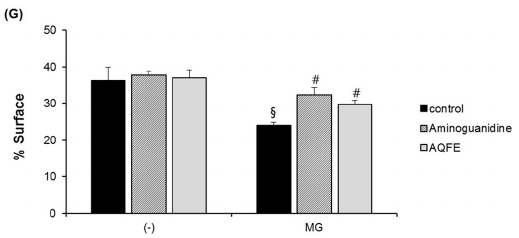
Figure 2. The explants were kept alive in a BEM culture medium for eight days with the vehicle and 1% AQFE. Fibrillin ‐ 1 immunostaining was conducted. Immunostaining of fibrillin ‐ 1 on untreated batch ( A ); treated with AG ( B ); treated with AQFE ( C ); treated with MG ( D ); treated with MG + AG ( E ) and treated with MG + AQFE ( F ). ( G ) Image analysis of the surface percentage occupied by fibrillin ‐ 1 under the dermal ‐ epidermal junction, as a function of the product applied. The average fluorescence intensity values were calculated using Image J software. Data are mean ± standard deviation. § p < 0.01 compared with the vehicle ‐ treated group; # p < 0.05 compared with the MG ‐ treated group ( n = 3). The results were confirmed by eight independent experiments.